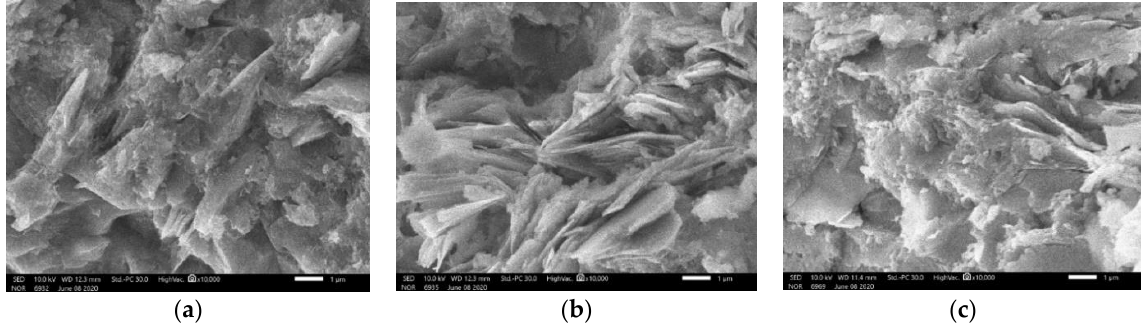
Figure 15. ( a-c ) Zoom of the geopolymer gels (at 1 µm) for specimens cured under ambient temperature.